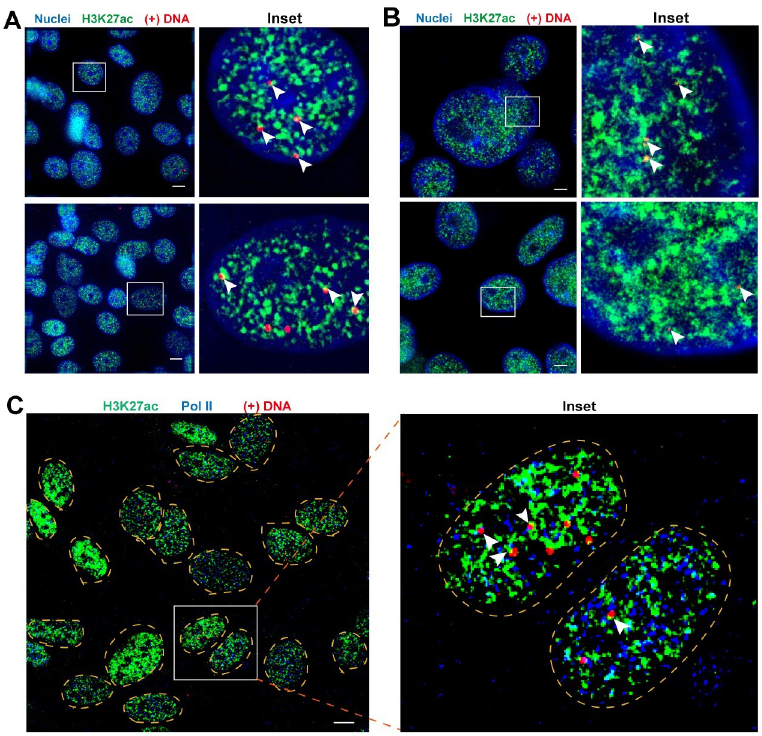
Fig 3. Colocalization of HBV (+) DNA with H3K27ac and Pol II proteins. HepG2-NTCP cells were infected with HBV at MOI = 1000 and at 12 days post-infection the cells were fixed and processed for viral (+) DNA detection followed by immunofluorescence staining for H3K27ac proteins with Alexa Fluor 488 labelled secondary goat anti- rabbit antibody and/or Pol II proteins with CY3 labelled secondary goat anti-mouse antibody. (A)/(C) Wide-field images. (B) Stimulated Emission Depletion (STED) super resolution images. Nuclei borders were represented by yellow dashed lines in (C). Scale bar, 4 μ m. Solid white arrows point to (+) DNA colocalized with H3K27ac or with H3K27ac and Pol II